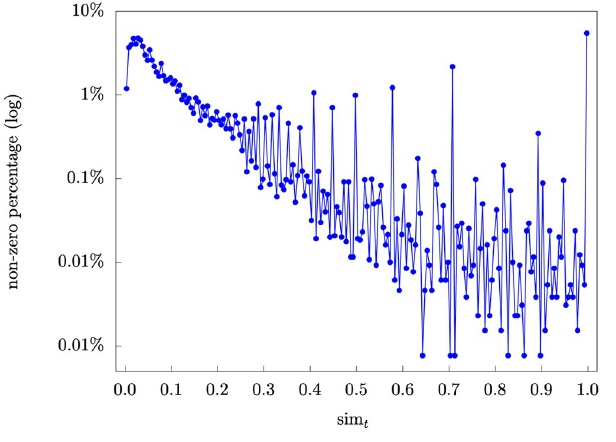
Fig 12. Term-term similarity